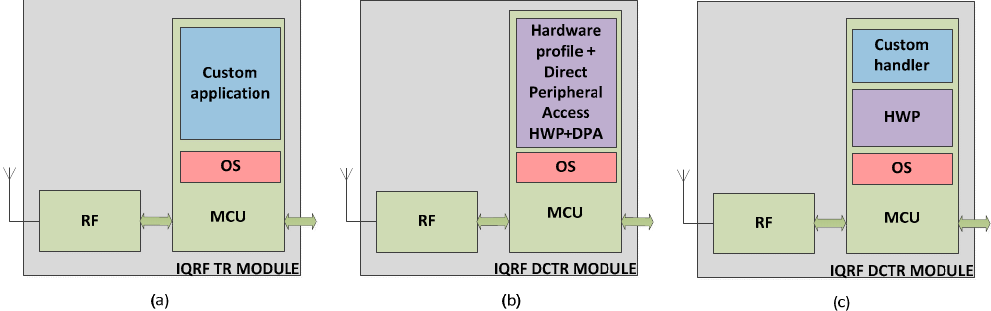
Figure 1. ( a ) Common transceiver; ( b ) data-controlled TR; ( c ) Data-Controlled Transceivers